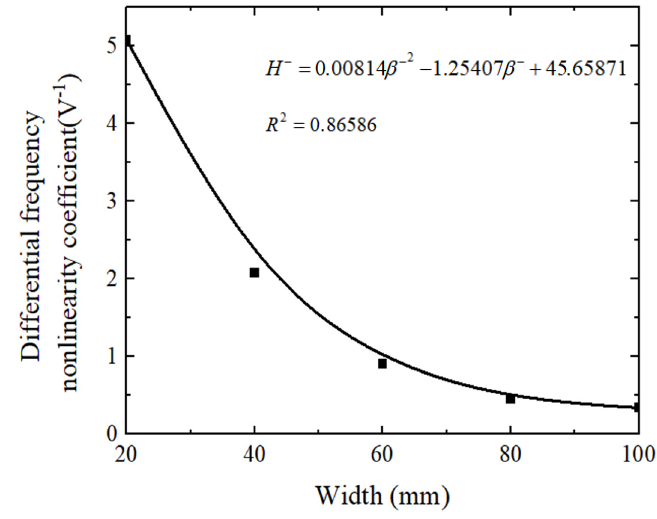
Figure 17. Variation of differential frequency factor with crack width.